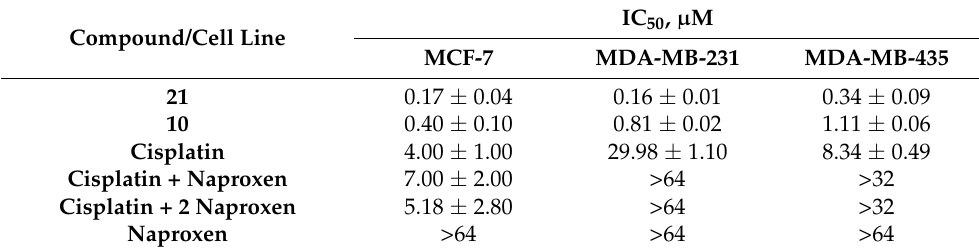
Table 10. Antiproliferative activity of cisplatin, equimolar mixtures of cisplatin and naproxen, and platinum(IV) prodrugs 21 and 10 on MCF-7 (breast cancer), MDA-MB-231 (triple negative breast adenocarcinoma), and MDA-MB-435 (triple negative breast adenocarcinoma) cell lines. Compound/Cell